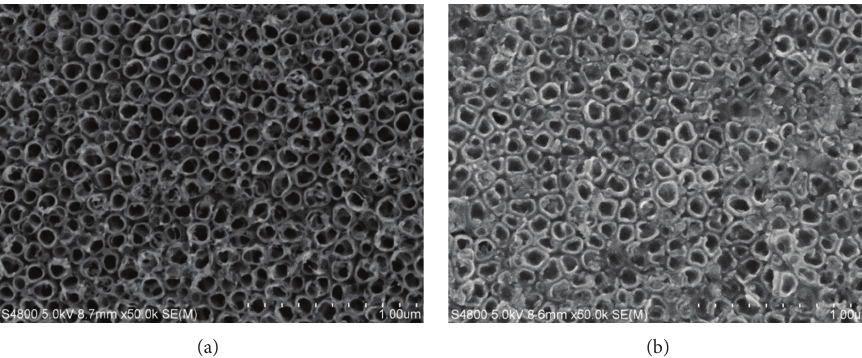
Figure1: Surface-view FESEMimages of (a)theunmodified TiO 2 NTsand (b)surfacemodified TiO 2 NTs by molecularly imprinted polymers (MIP-TiO 2